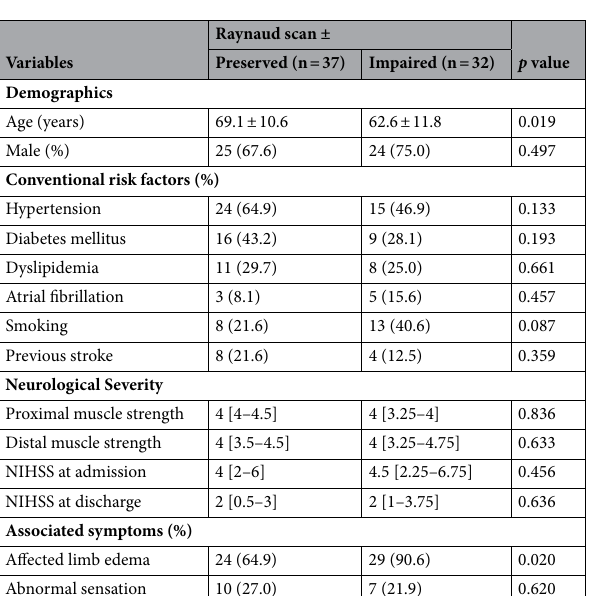
Figure 2. Modified Raynaud scan of impaired vasoreactivity case. ( A ) High signal intensity in right anterior cerebral artery territory on a diffusion-weighted image. ( B ) Scan for both hands and standard source. ( C ) Same blood amount in both hands. Activity % of the total injected dose means the percentage of total blood. ( D ) Impaired vasoreactivity in the left hand under thermal stress. The amount of blood in the right hand was stable during the scan. The shaded area in Fig. 1 ( C , D ) represents the reference range obtained from 10 normal volunteers. R: right; L: left; Std: standard.